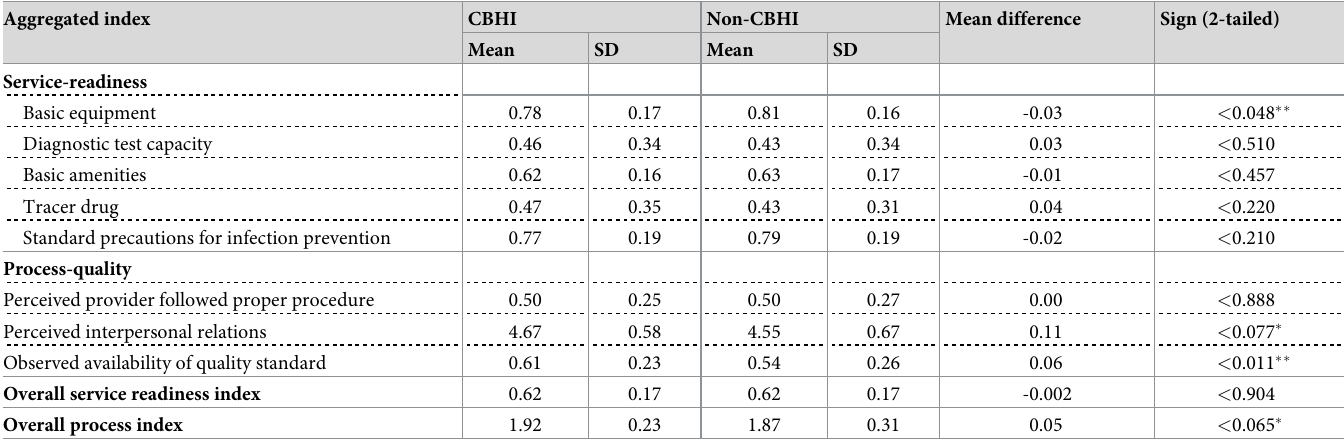
Table 2. Descriptive statistics for service-readiness and general-process-score